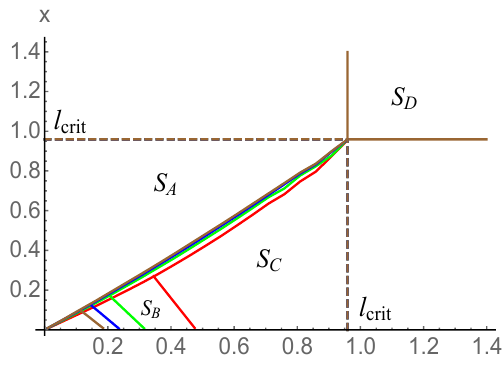
Figure 11 . The n strip phase diagram of various entangling surfaces in the thermal-AdS background. The red, green, blue and brown curves correspond to n = 2, 3, 4 and n = 5 respectively. In units